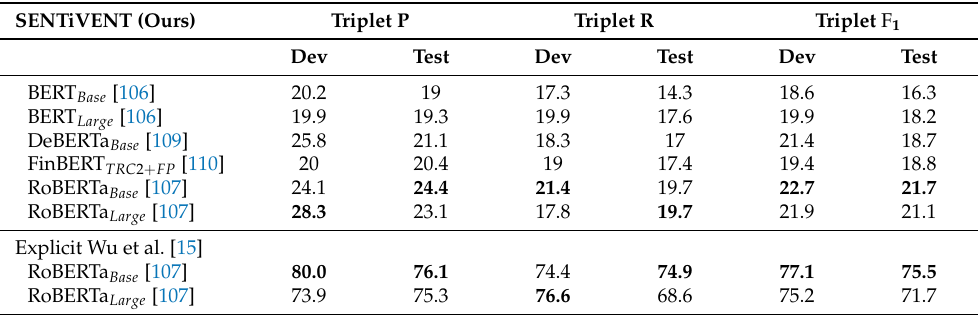
Table 9. Fine-grained token-level implicit sentiment results on the development set and holdout test set for winning models after optimizing hyperparameters for each architecture. Precision (P), recall (R), and F 1 -score (F 1 ) percentages are micro-averaged.